Question: Provide a one-line summary of what is displayed.
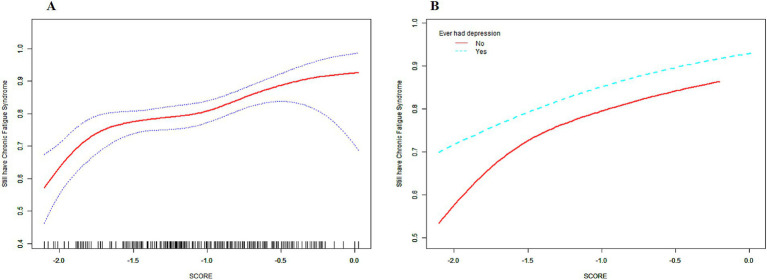
Answer: Nonlinear relationship between disease history score and current myalgic encephalomyelitis/chronic fatigue syndrome: (A) Total participants, (B) subgroup analysis in terms of depression history.